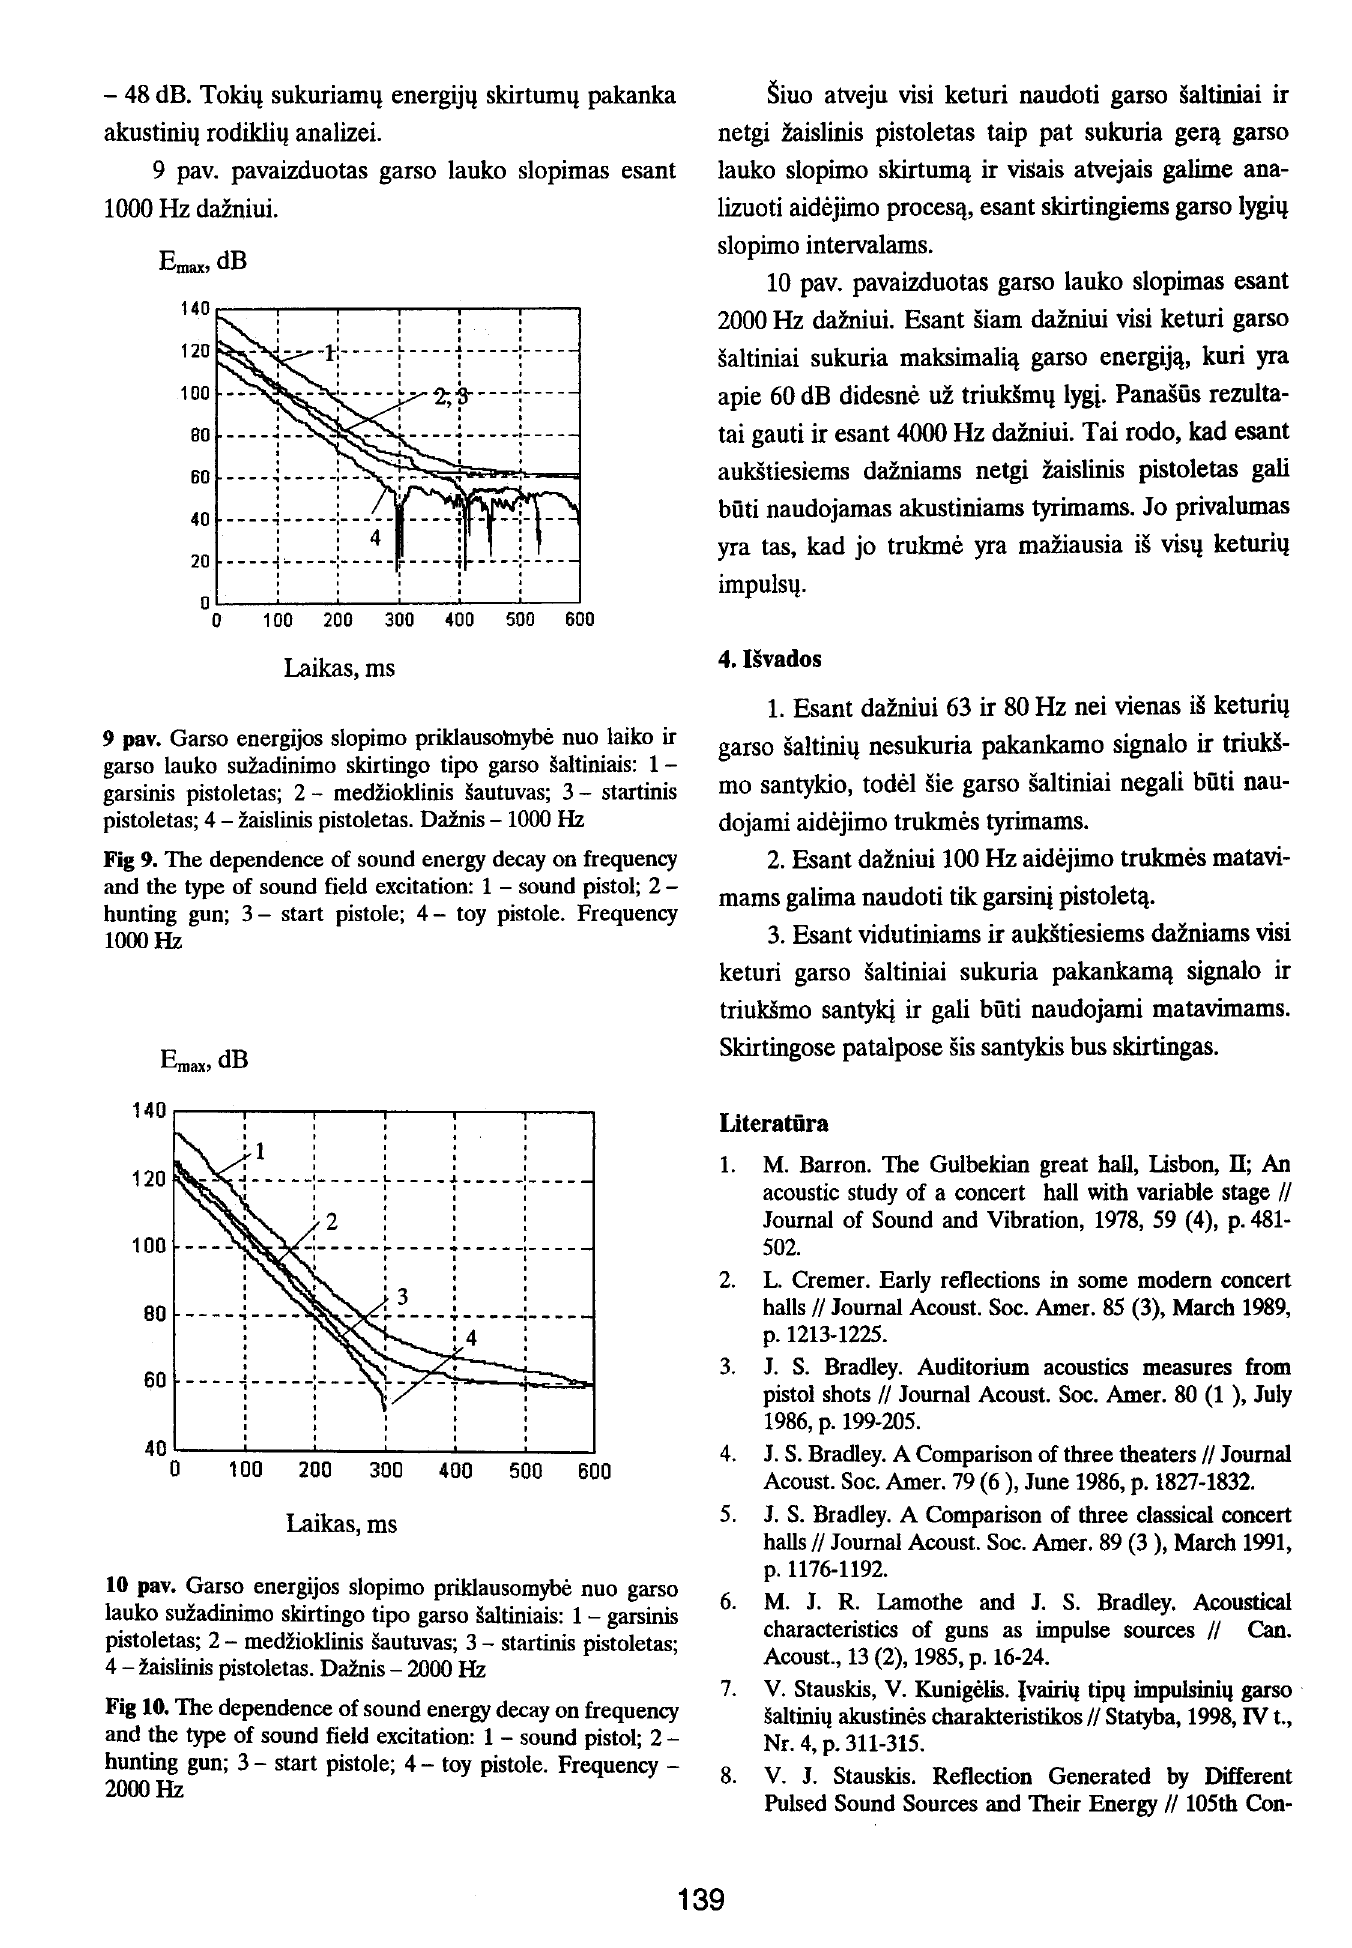
pistoletas; 2 - medzioklinis sautuvas; 3 - startinis pistoletas; 4 - zaislinis pistoletas. Damis - 2000 Hz Fig 10. The dependence of sound energy decay on frequency and the type of sound field excitation: 1 - sound pistol; 2 - hunting gun; 3 - start pistole; 4- toy pistole. Frequency